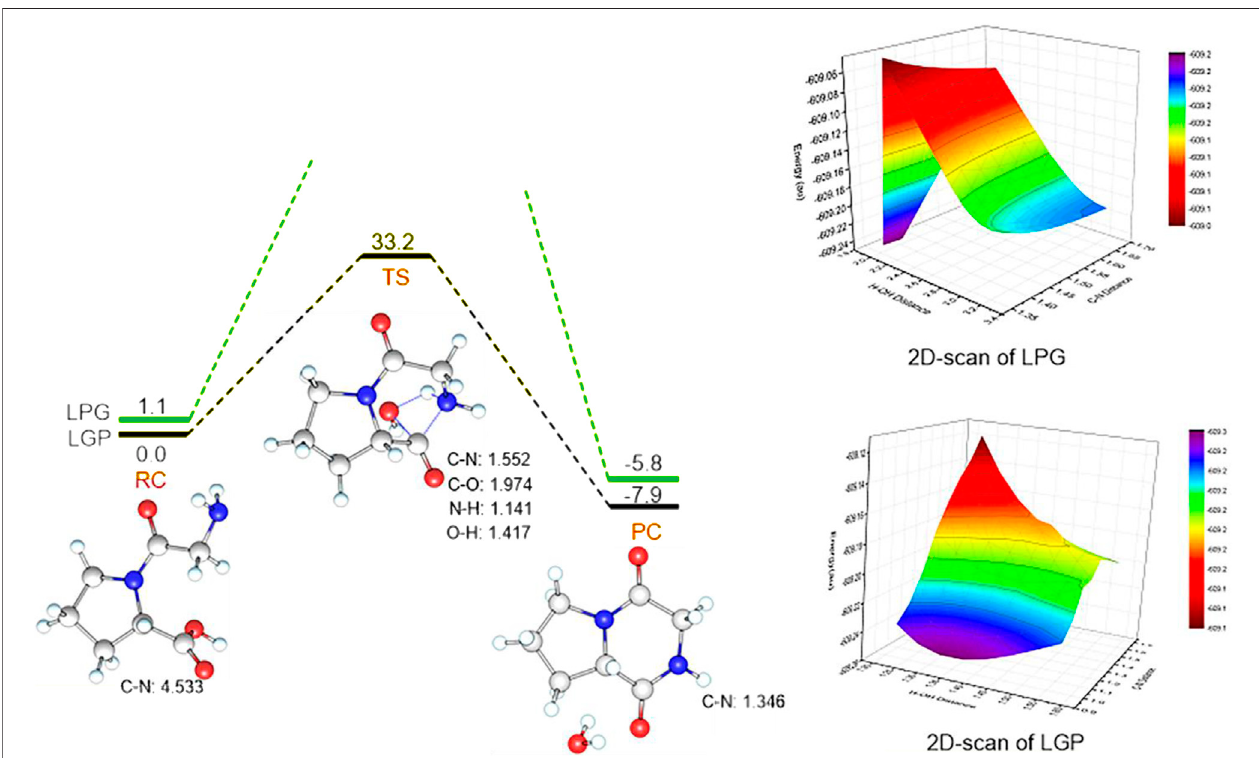
FIGURE 2 | Energy pro fi les (in kcal · mol − 1 ) for the Linear-Gly-Pro and Linear-Pro-Gly to form cyclo-Pro-Gly. Key geometric information on transition states is presented. Energies are in kcal mol − 1 units, lengths are in Å units, angles are in degree units. LPG: Linear-Pro-Gly; LGP: Linear-Gly-Pro.